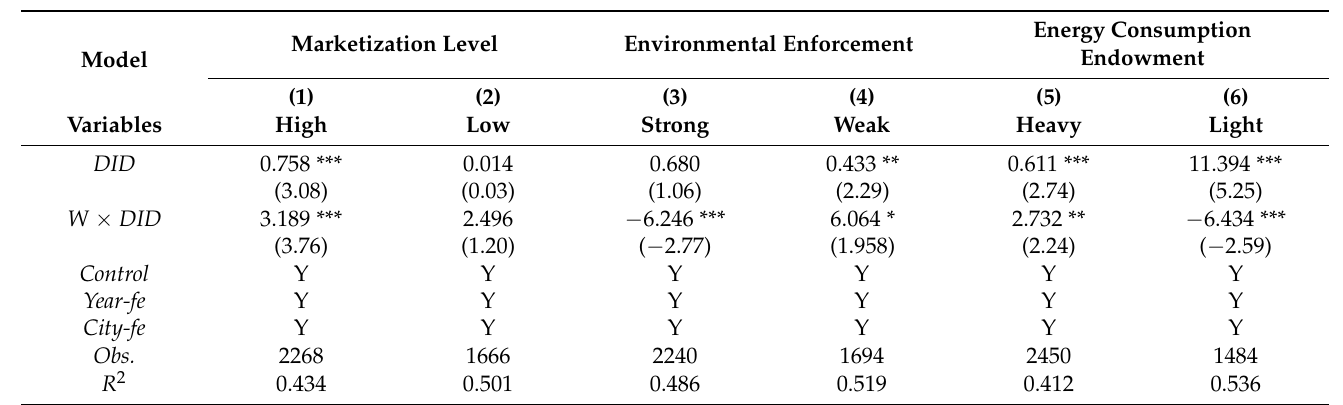
Table 3. Heterogeneity analysis